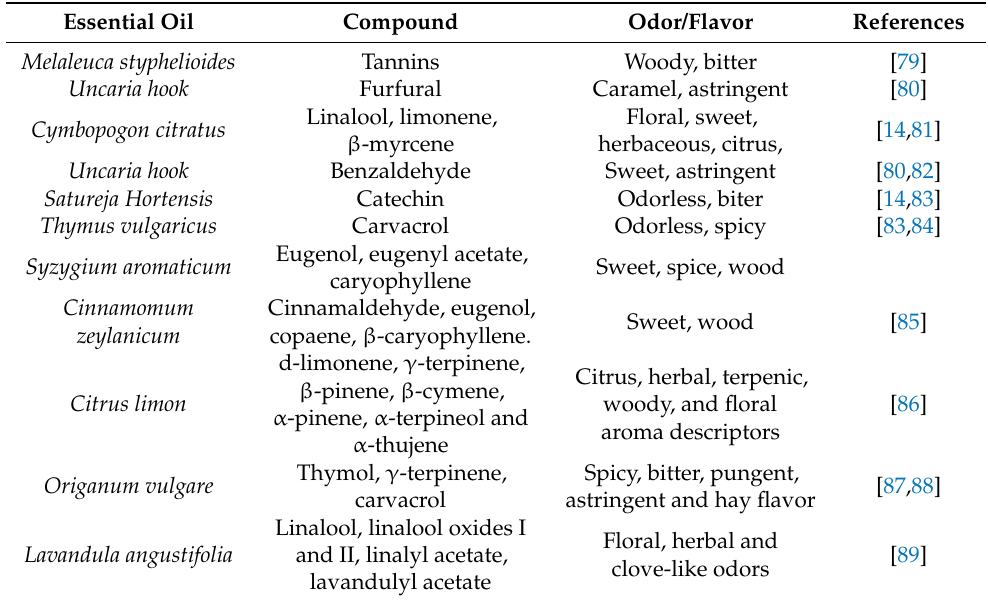
Table 4. Examples of sensory attributes (odor and flavor) of some essential oils with antibacterial and antioxidant properties.